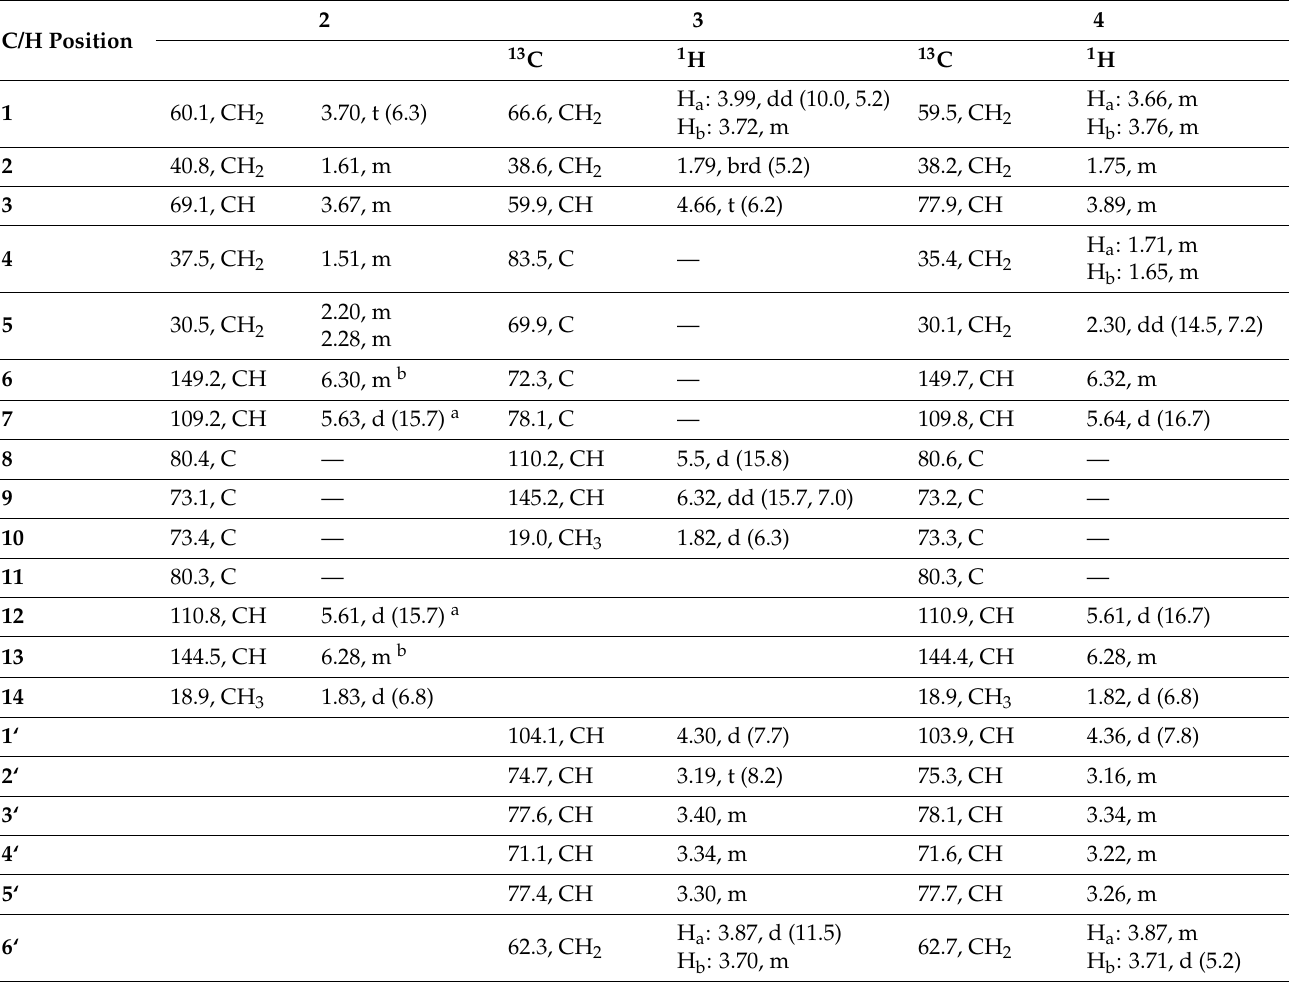
Table 2. 1 H (500 MHz, CD 3 OD) and 13 C (125 MHz, CD 3 OD) NMR spectral data of compounds 2 – 4 ( J in